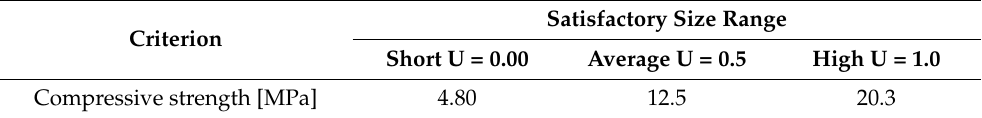
Table 1. Satisfactory size ranges for the criterion of optimizing the composition of silicate mass modified with glass sand (GS) as a substitute for QS quartz sand in the presence of water (H 2 O).